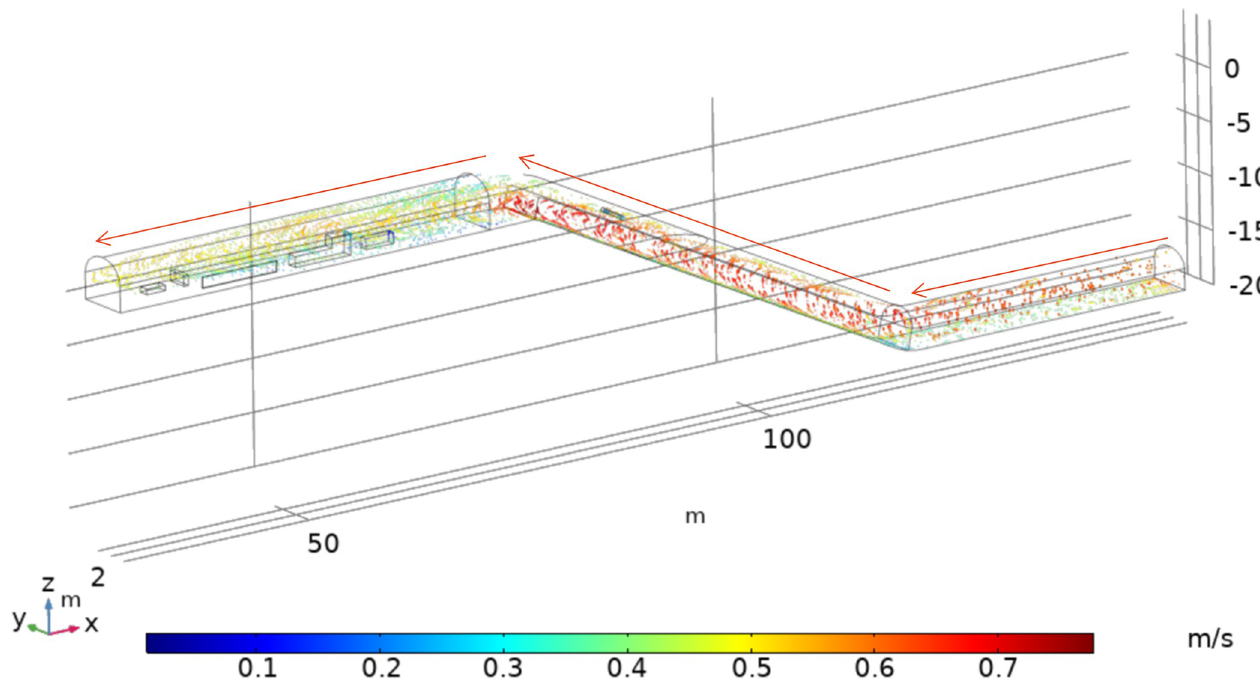
Fig 9. Return wind flow—coal dust velocity